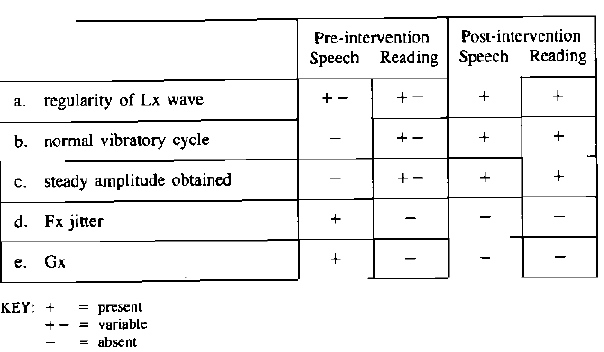
Figure 2a Example of post-intervention spontaneous speech laryngographic tracing a. Regularity of the wave — the post-intervention tracings reflect tory pattern of the vocal folds.